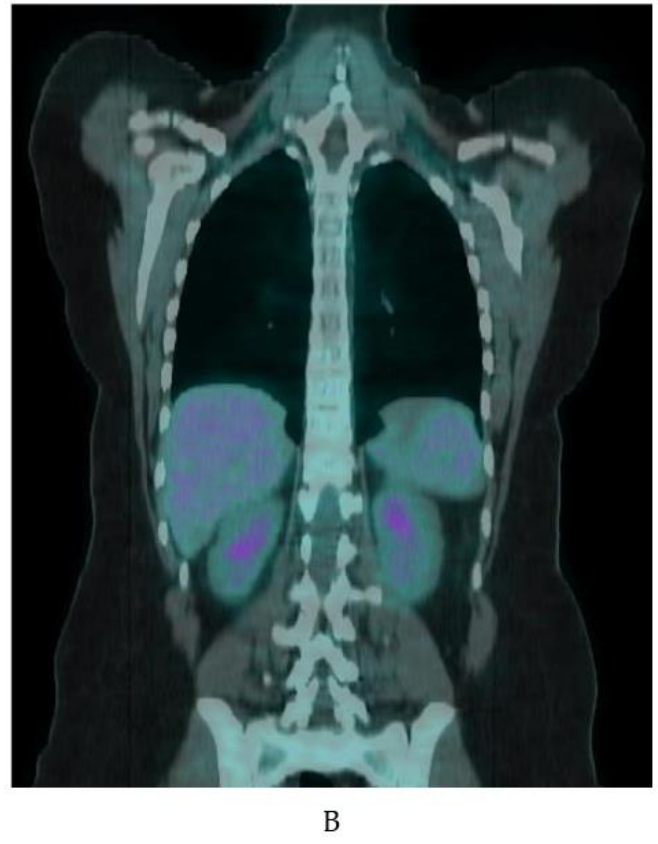
Figure 5. Example of variable iBAT uptake on FDG-PET / CT. FDG-PET / CT in a woman in her 20s showing marked BAT uptake in ( A ) November (yellow arrows) and no detectable BAT FDG uptake on a scan ( B ) 6 months later.